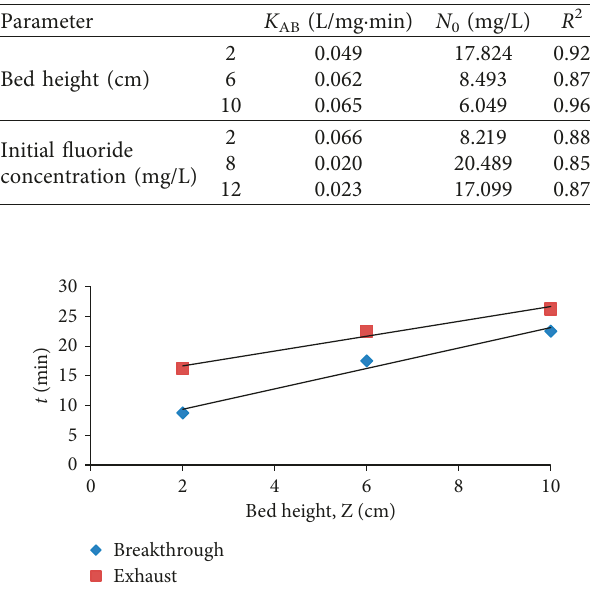
Figure 12: Plot of BDST model of QPKS.